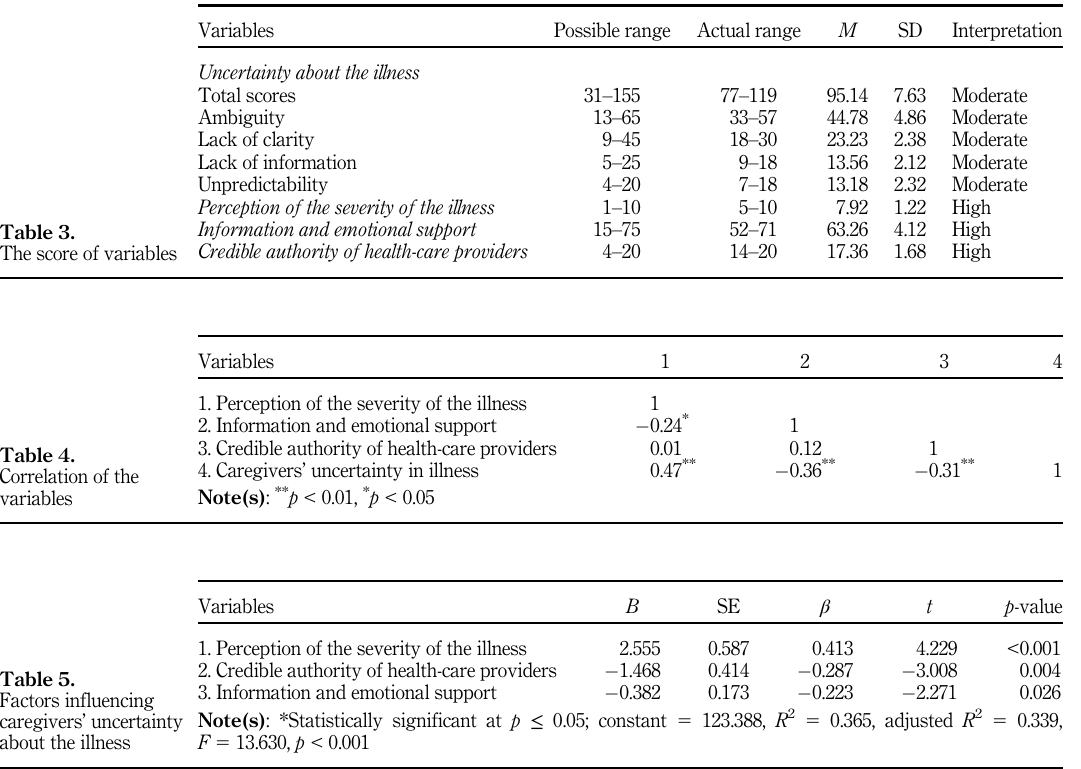
Table 5. Factors influencing caregivers ’ uncertainty about the illness